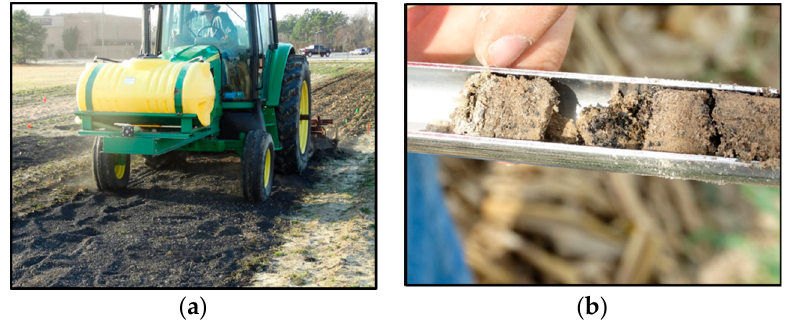
Figure 1. ( a ) Physical mixing of biochar using disk; ( b ) soil core into top 0–10 cm soil